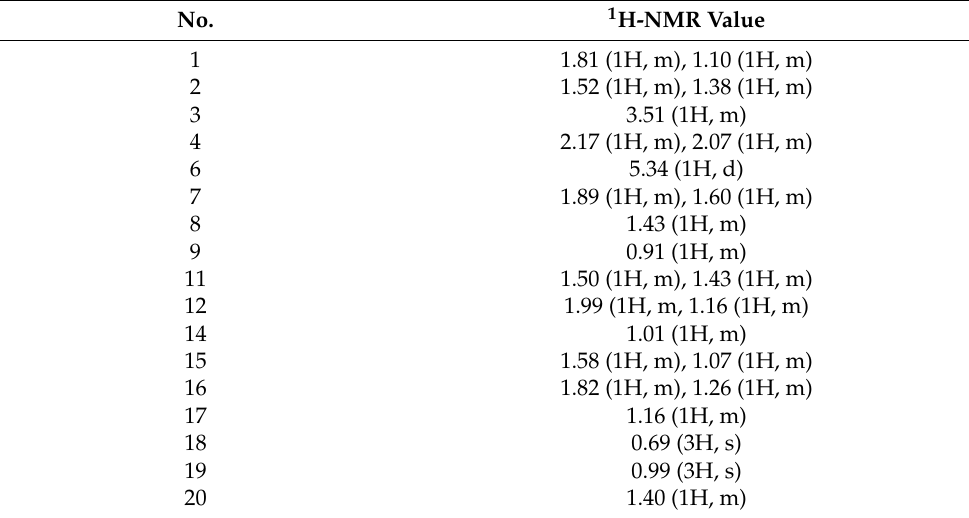
Table 2. Numerical values of spectra of the 1 H-NMR values of